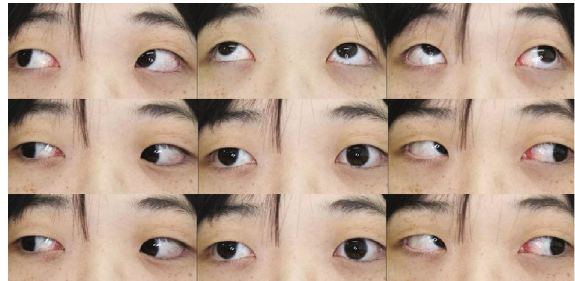
Figure 1: The patient ’ s eye movement examination. The examination revealed overelevation of the right eye in adduction and restriction in the superior oblique muscle direction of the right eye, whereas movements of the left eye were almost